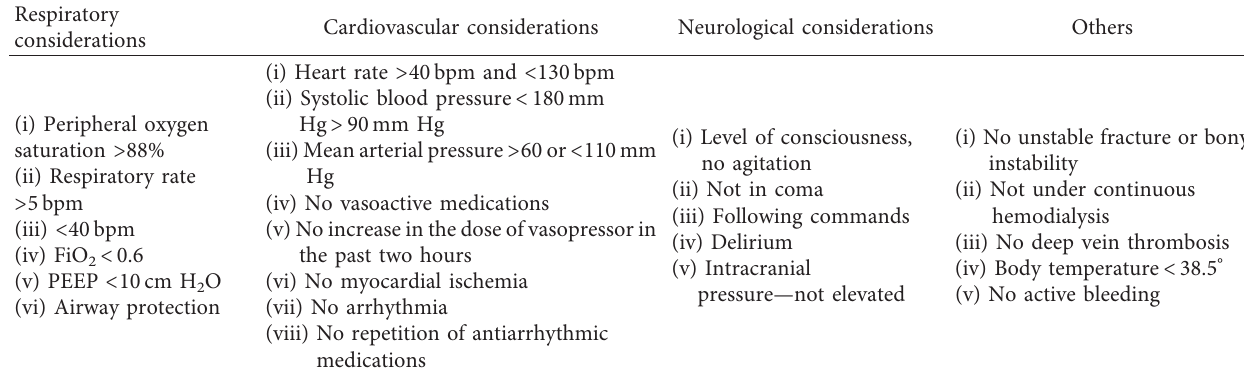
Table 5: Safety measures for early mobilization in the intensive care